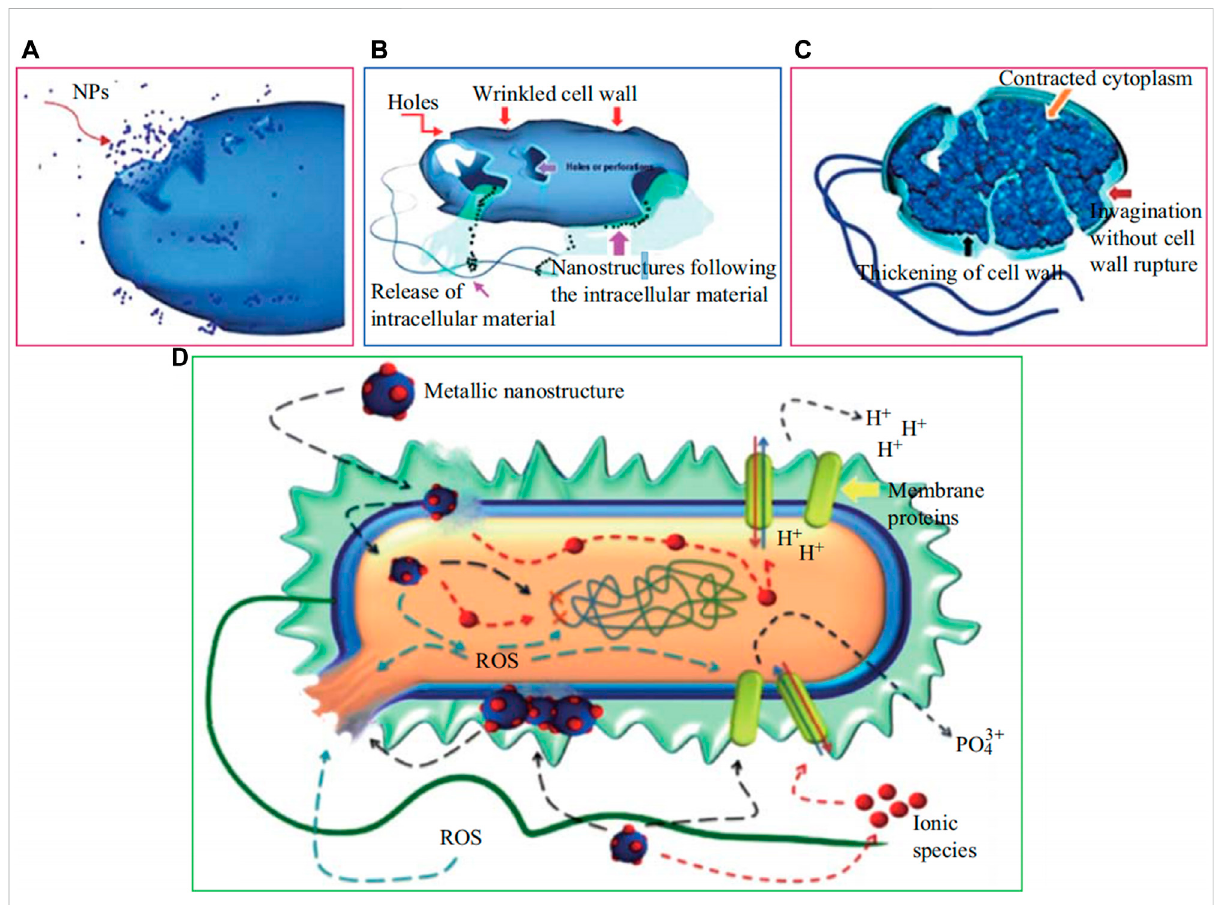
FIGURE 4 (A) Nanoparticlesinternalizationintothecellwallandtranslocation. (B) Disruptionofcellwallandreleaseofintracellularmaterials. (C) Variations in envelope composition of cell wall and extrusion of cytoplasm. (D) Probable mechanisms, include the following: metal ions uptake into cells, intracellular depletion, and disruption of DNA replication, release of metal ions and ROS generation, accumulation and dissolution of NPs in the bacterial membrane (Sirelkhatim et al.,